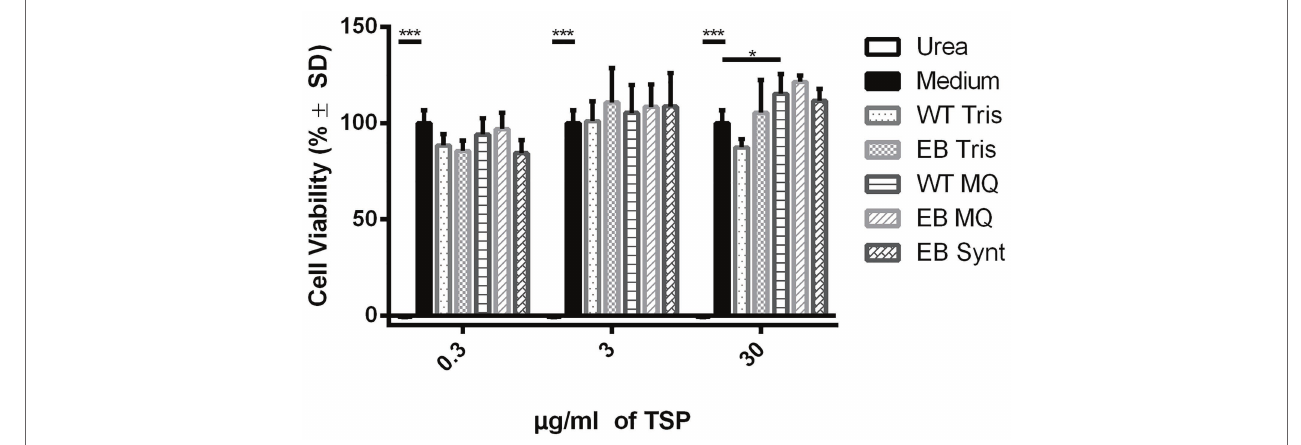
FIGURE 5 | The cell viability is not affected for EB extracts. The EB and WT extracts in Tris and Milli Q water and the EB synthetic peptide (0.03, 3, and 30 μ g/ml) did not decrease cellular viability in comparison with medium control ( p < 0.001, ANOVA). Dunnett’s multiple comparisons test (*** = 0.001; * = 0.1). The % cell viability was determined by MTT reduction. Urea (4 M) was used as a negative control of cell viability reduction, and MEM medium was used as a positive control of cell viability reduction. (MQ): Milli Q water extracts; (TRIS): Tris Buffer extracts.